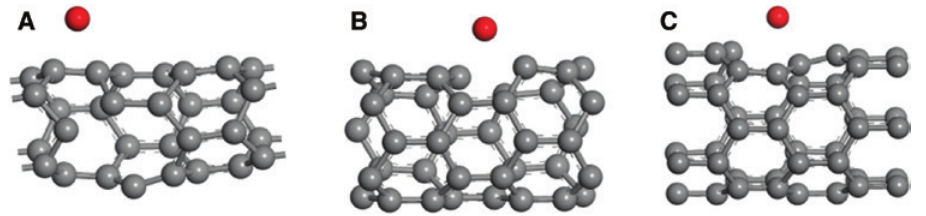
Figure 2: The optimized configurations of Pb 2 + -SV-(n, 0) CNTs (n = 4, 5, 6); the red ball is Pb